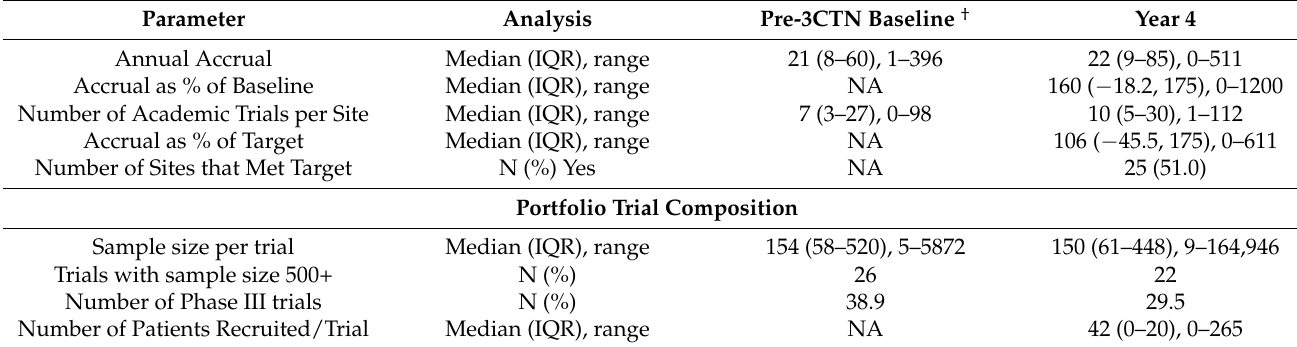
Table 2. Network site data and Portfolio trial composition analysis outcomes.